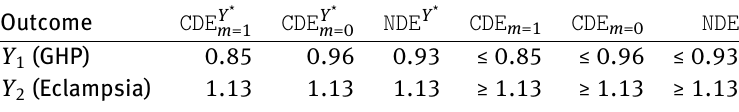
Table 1: The estimated conditional direct effects and true conditional direct effects of ethnicity, assuming the true effects on Y 1 is less than or equal to 1, the true effects on Y 2 is greater than or equal to 1. Mislabeling eclampsia as gestational hypertension